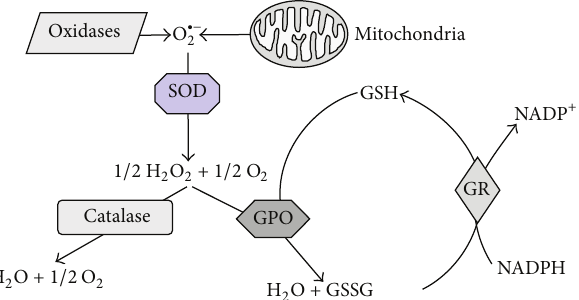
Figure 2: Schematic illustration of the endogenous defence sys- tem against intracellular oxidative stress. CAT: catalase, GPO: glutathione peroxidase, GR: glutathione reductase, GSH/GSSG: reduced glutathione/oxidized glutathione, SOD: superoxide dismu-